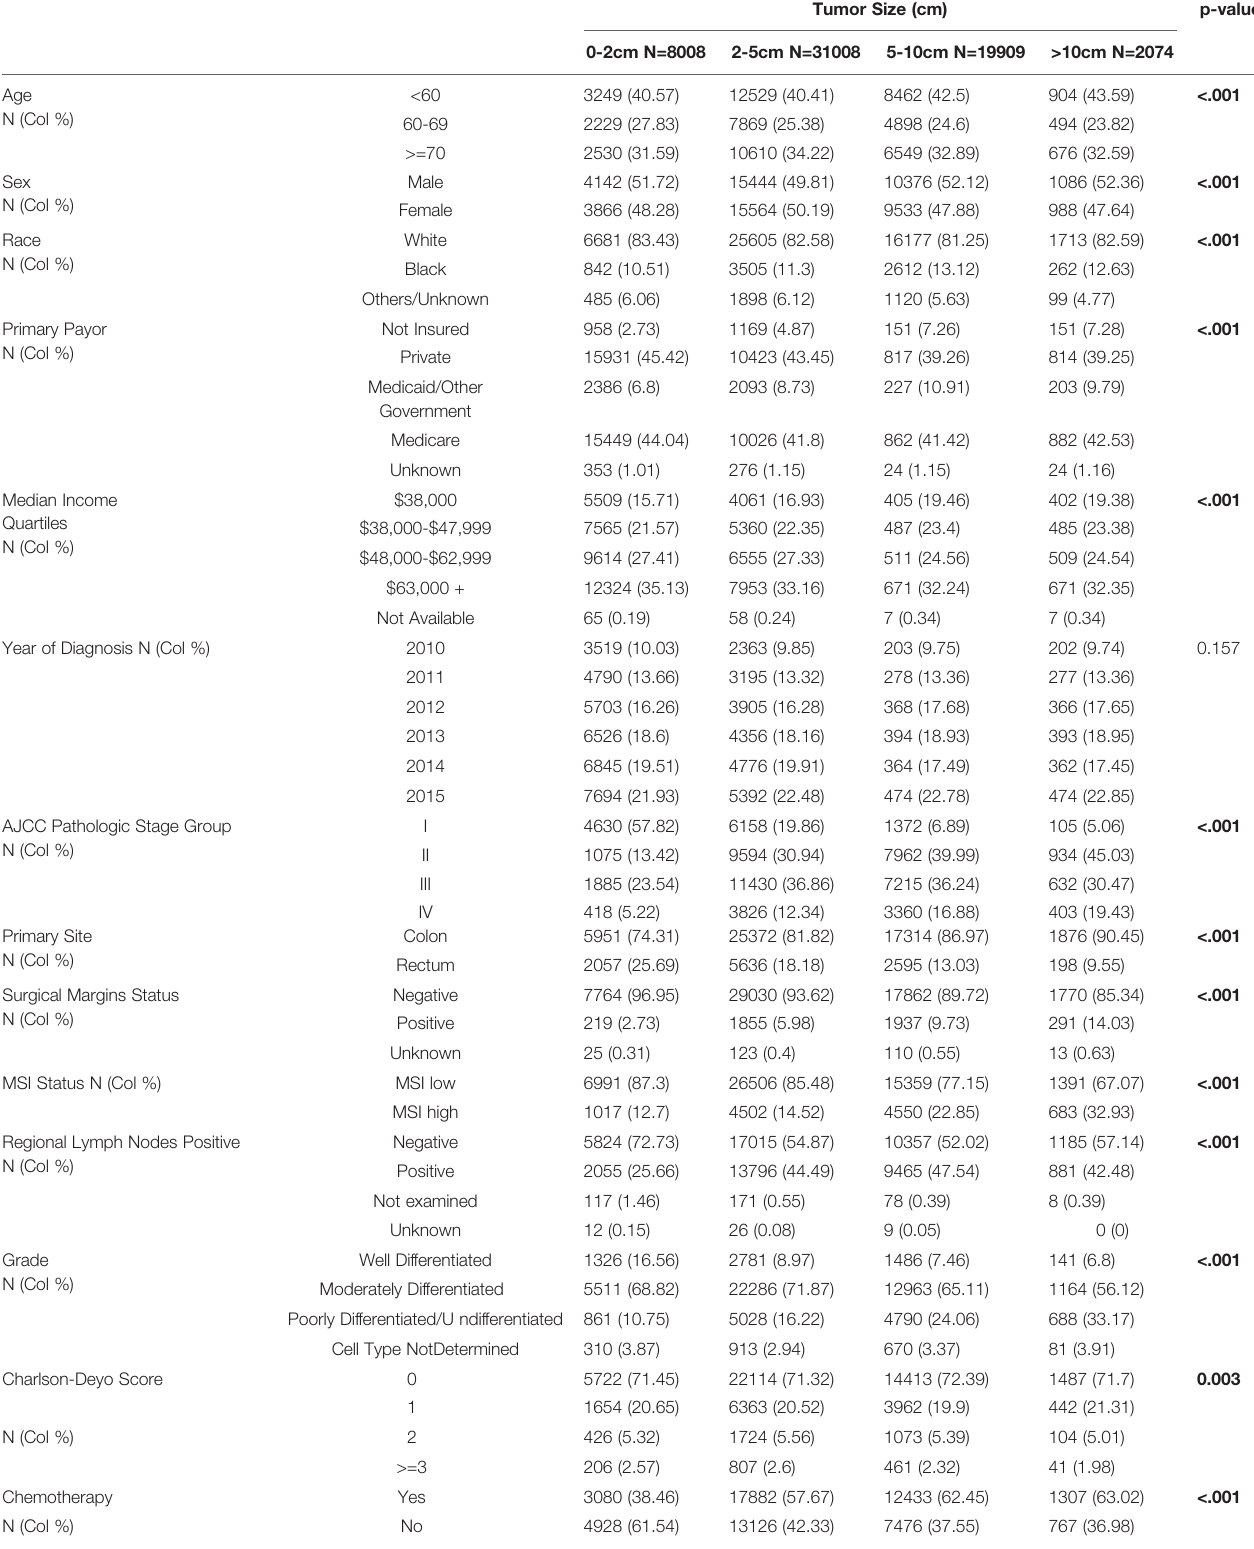
TABLE 2 | Univariate correlation with tumor